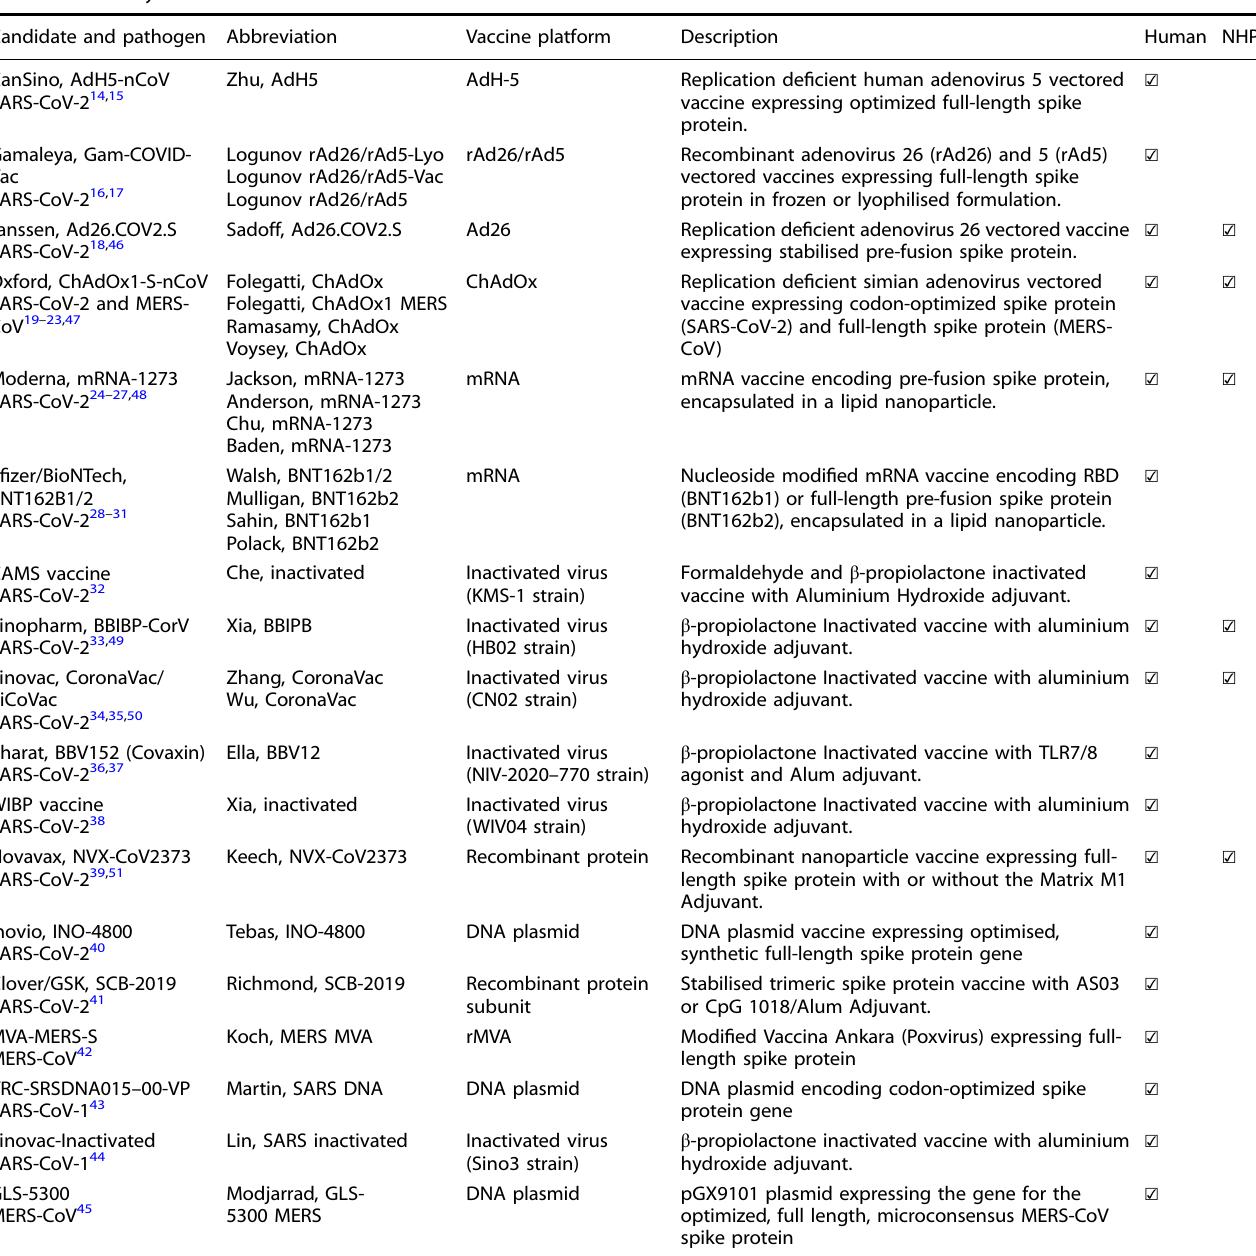
Table 1. Summary of human vaccine